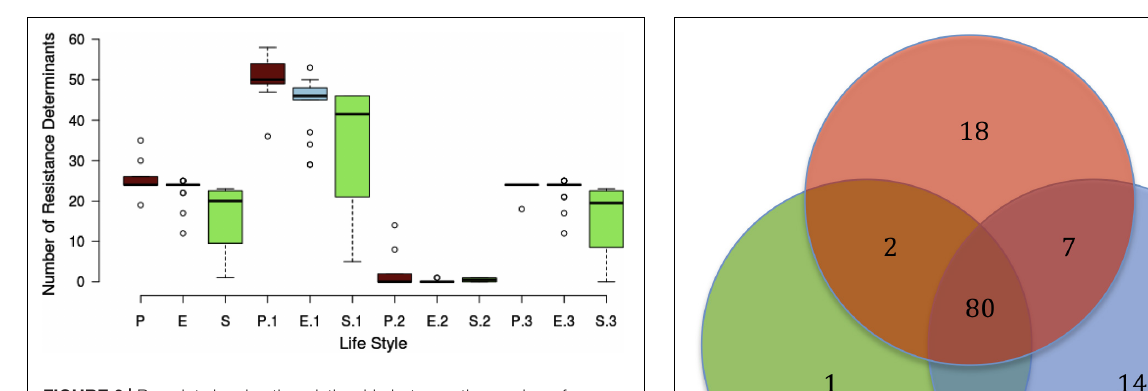
gene, qnr , are shared by the majority of the strains,